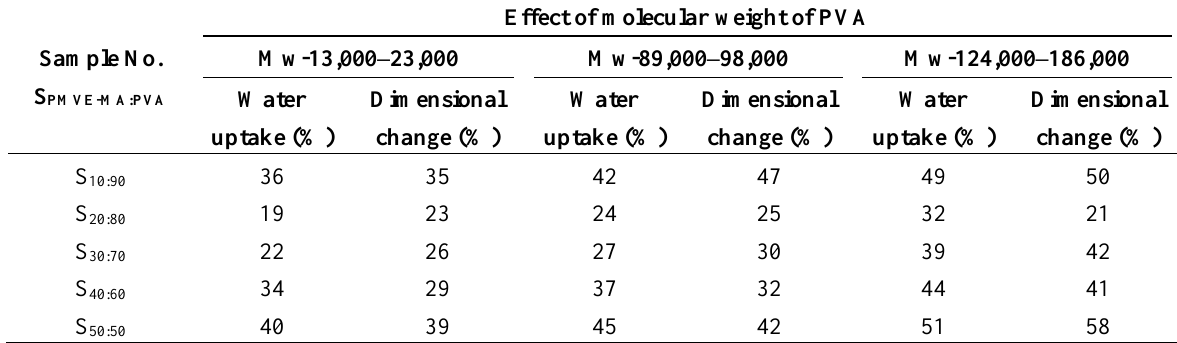
Table 1. Water uptake and dimensional change of cross-linked PVA/PMVE-MA blend membranes for different molecular weight PVA with various blend ratios. Values are means ±